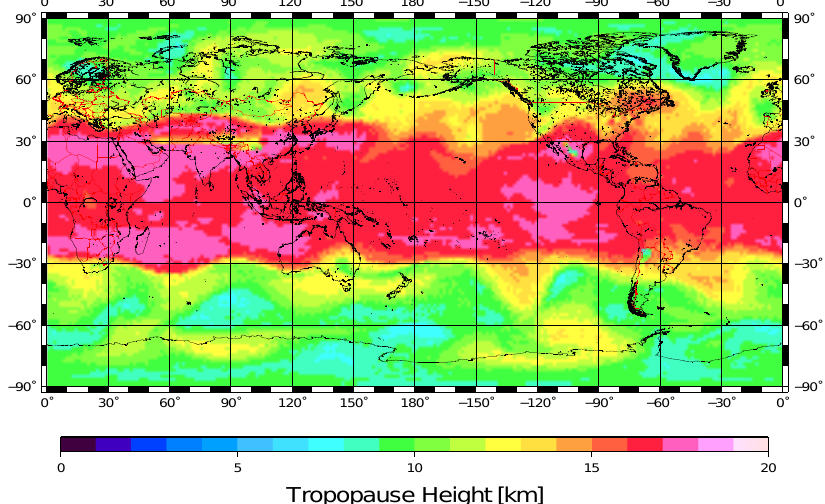
Figure 2. Distribution of global tropopause height on 28 June 2005 derived from the ECMWF ERA-Interim re-analysis.